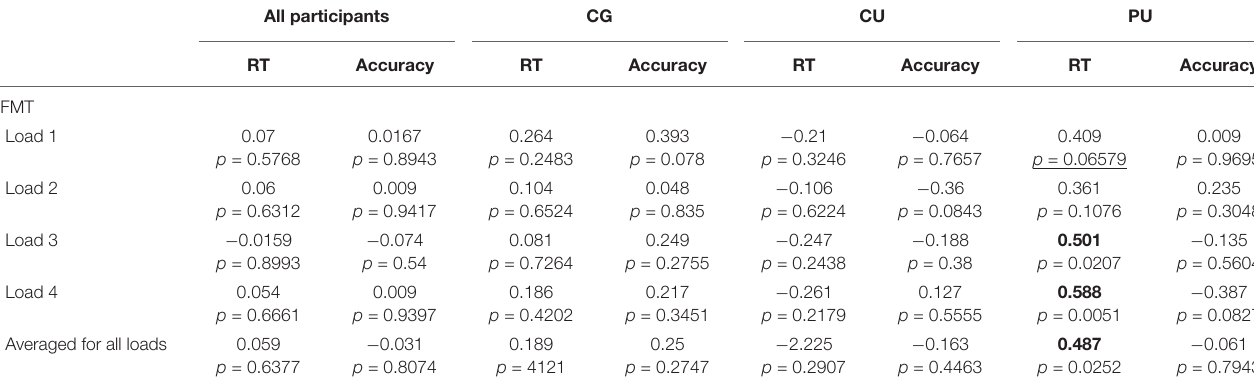
TABLE 3 | Pearson coefficients for correlations (with p value reported) between RT and accuracy and frontal midline theta (FMT) during maintenance, at all WM loads and averaged across all memory loads for all participants and each group separately: control group (CG), cannabis users (CU), and polydrug users (PU). All participants CG CU PU